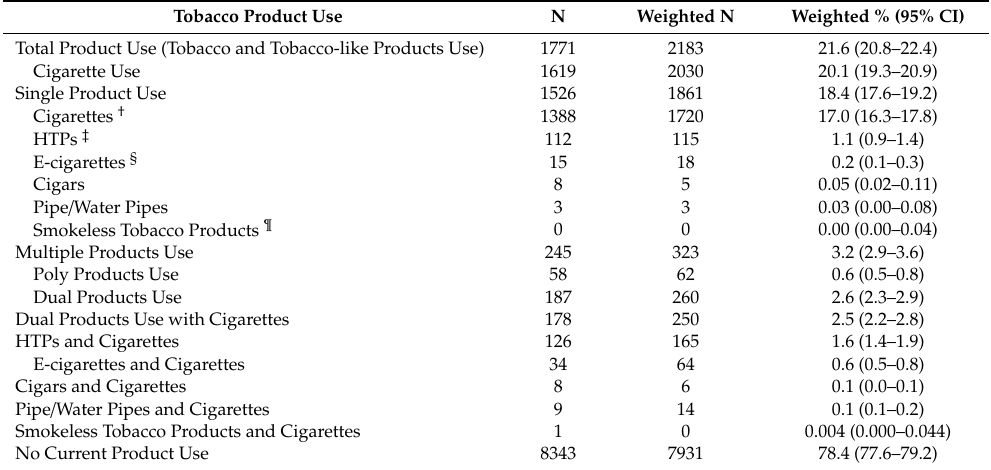
Table 1. Prevalence of total, single, and multiple current products use * among participants in Japan (N = 10114). Tobacco Product Use N Weighted N Weighted % (95%